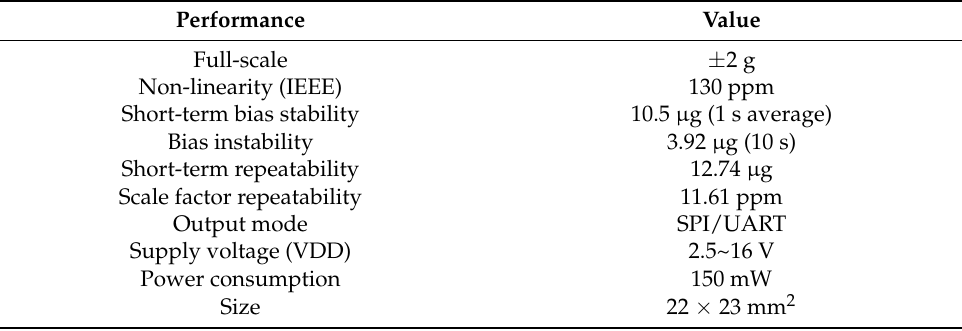
Table 2. Performance statistics of the closed-loop accelerometer.